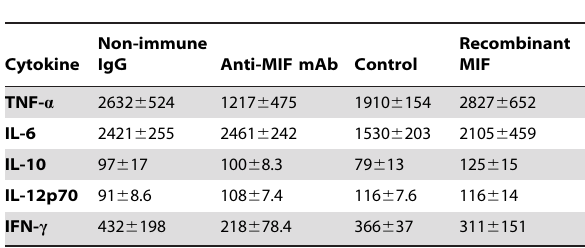
Table 1. Cytokine concentrations (pg/ml) in lung homogenates of mice treated with anti-MIF antibodies or recombinant MIF during experimental